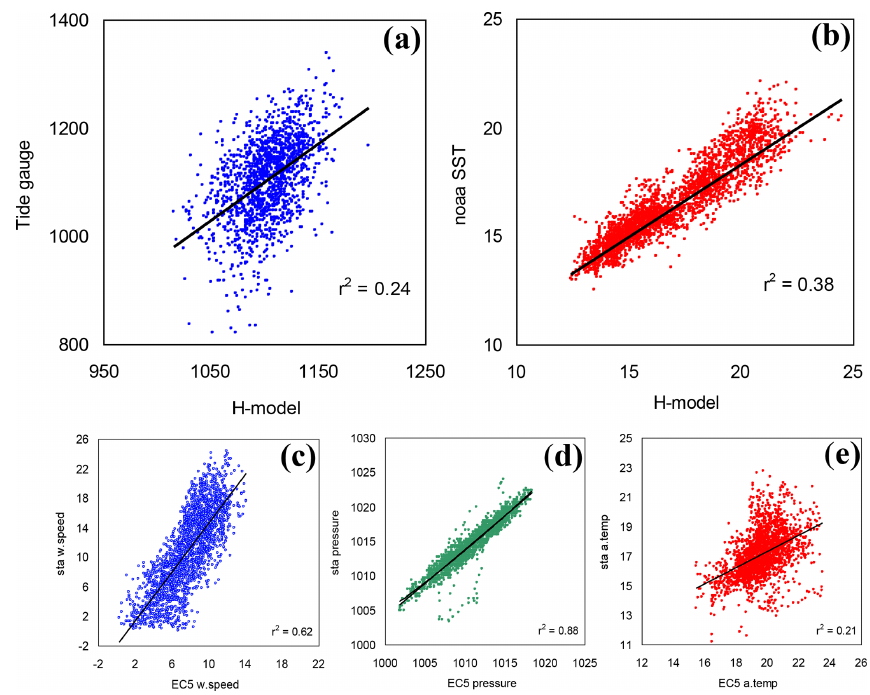
Figure A1. Comparison of daily HYCOM model at nearest grid point and (a) sea surface height from tide gauge off Simonstown in western False Bay (cf. Fig. 1b) and (b) sea surface temperature from NOAA satellite; 2008–2015. Bottom: comparison of hourly ECMWF v5 reanalysis at nearest grid point and weather station observation off Simonstown in western False Bay, 1 December 2012–28 February 2013: (c) wind speed, (d) pressure, and (e) air